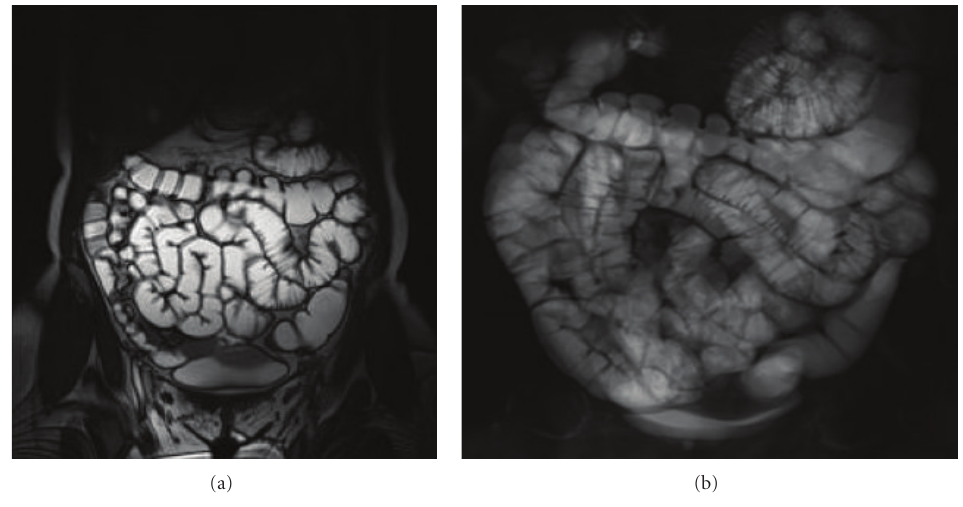
Figure 6: MR-E. (a), (b) Coronal true fast induction steady-state potential and single-shot hydrographic sequence showing a suitable degree of jejunum distension.